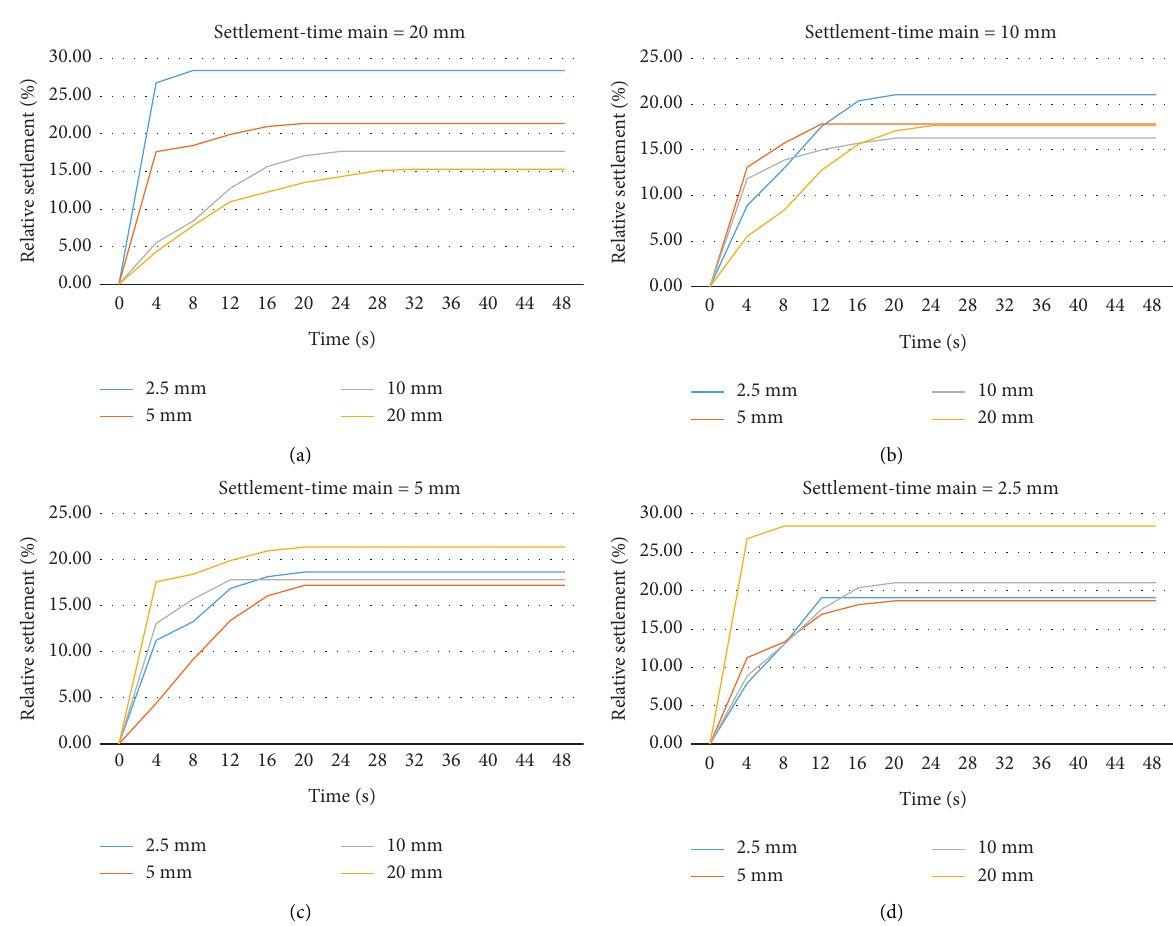
Figure 17: Percentage of relative settlement over time for rounded aggregates with a weight mixture equal to 2.5, 5, 10, and